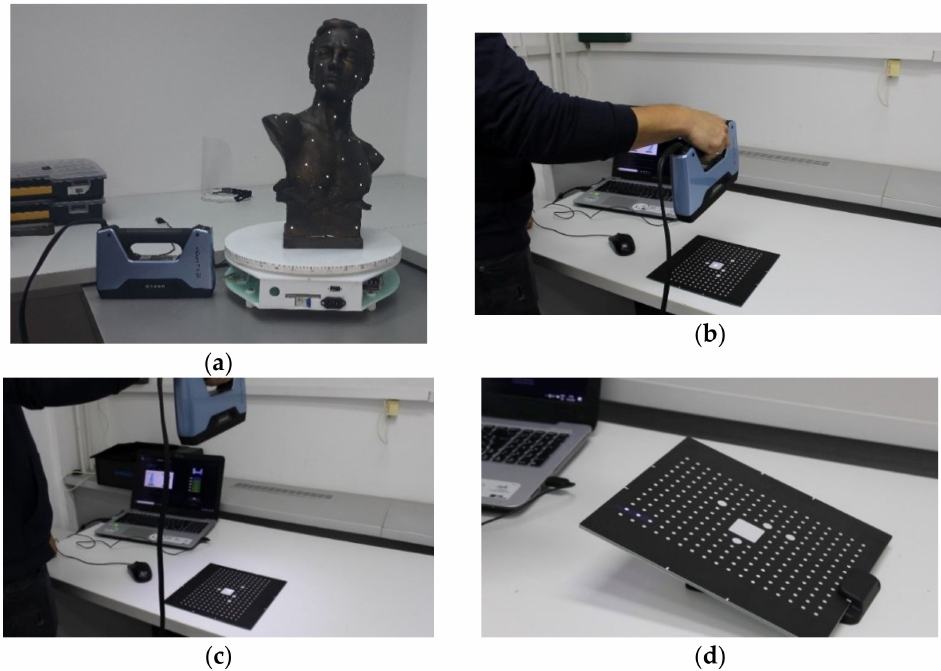
Figure 5. EinScan 2X Pro scanner: ( a – d ) different positions of the calibration board and scanner. The precision of this scanner for Handheld HD Scan mode goes up to 0.05 mm